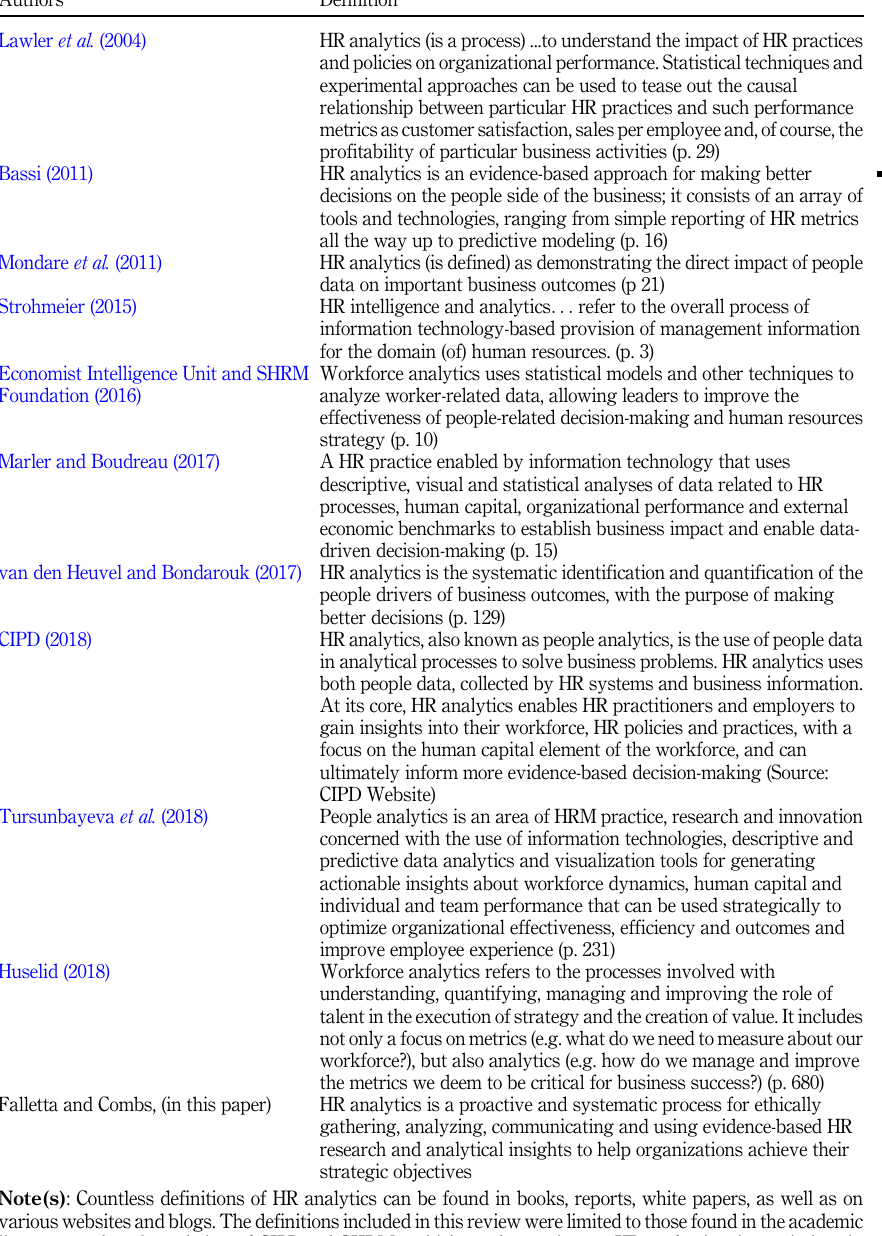
Table 2. HR analytics